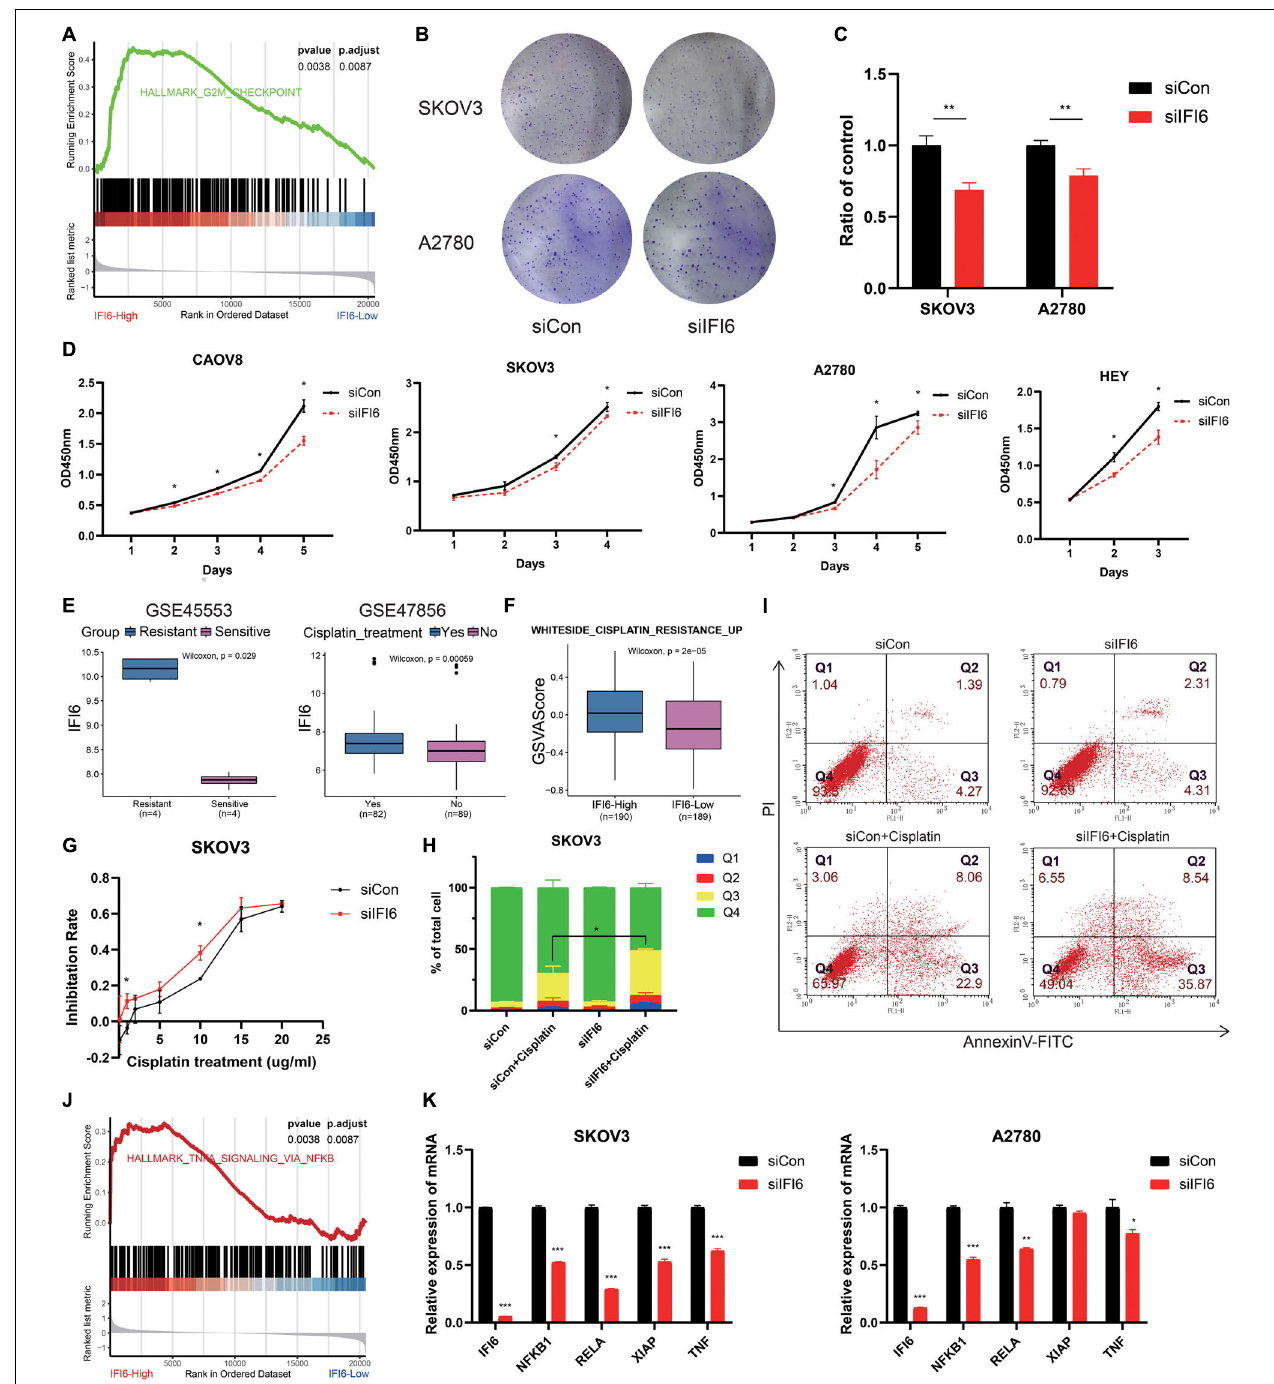
FIGURE 6 | Potential mechanism of IFI6 promoting OC proliferation and cisplatin resistance may be related to the NF- κ B pathway. (A) GSEA showing high-IFI6 groups is associated with G2M checkpoint in the TCGA OC dataset. (B,C) Effect of IFI6 on the colony formation of OC cells by plate colony formation assay. (D) CCK-8 assays demonstrating slower proliferation in IFI6 silent cells compared to the siCon cells. (E) Box plot illustrating higher IFI6 in the cisplatin-resistant and relapse group based on GEO datasets. (F) GSVA of WHITESIDE_CISPLATIN_RESISTANCE_UP in high- and low-IFI6 groups. (G) Cisplatin sensitivity in siCon and siIFI6 in SKOV3 cells. (H,I) Apoptotic cells by flow cytometry in control and siIFI6 in SKOV3 untreated or treated with cisplatin. The p -value of apoptosis (Q3) between the groups siCon+Cisplatin and siIFI6+Cisplatin is < 0.05. (J) GSEA presenting higher IFI6 is associated with the NF- κ B pathway. (K) Compared with control cells, the expressions of NFKB1, RELA, XIAP, and TNF are lower in siIFI6 cells in mRNA level.